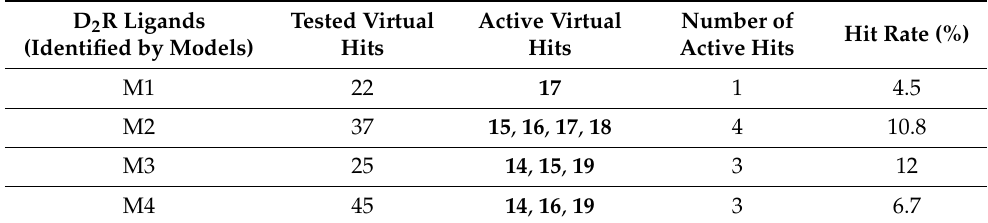
Table 5. Prospective performance of the pharmacophore models generated in DS and